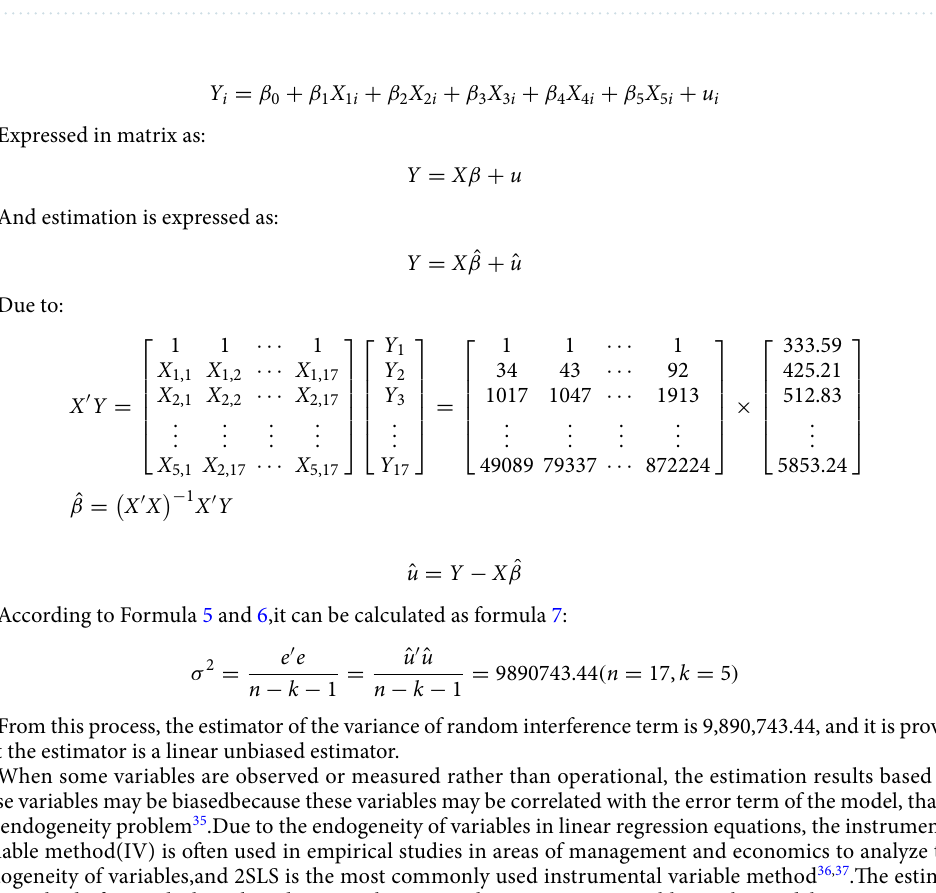
Table 4. Regression analysis of total factor productivity indicators of Guangxi construction industry. Stock- Yogo critical values in 15% level are in parentheses in the table,Cragg-Donald F-stat value not less than Stock- Yogo critical values in 15% level implies rejection of the original hypothesis of Weak Instrument